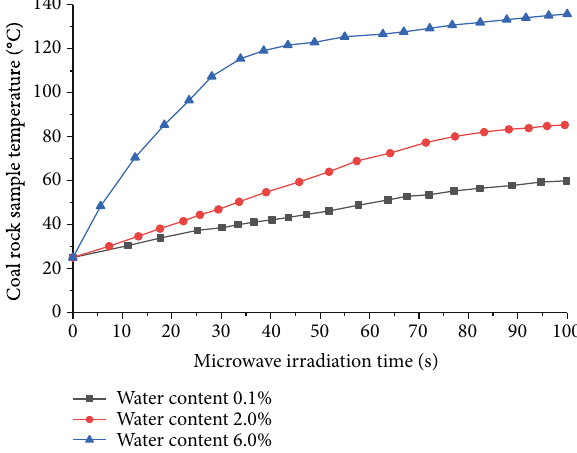
Figure 5: Changes in internal temperature with time of coal rock samples with di ff erent water